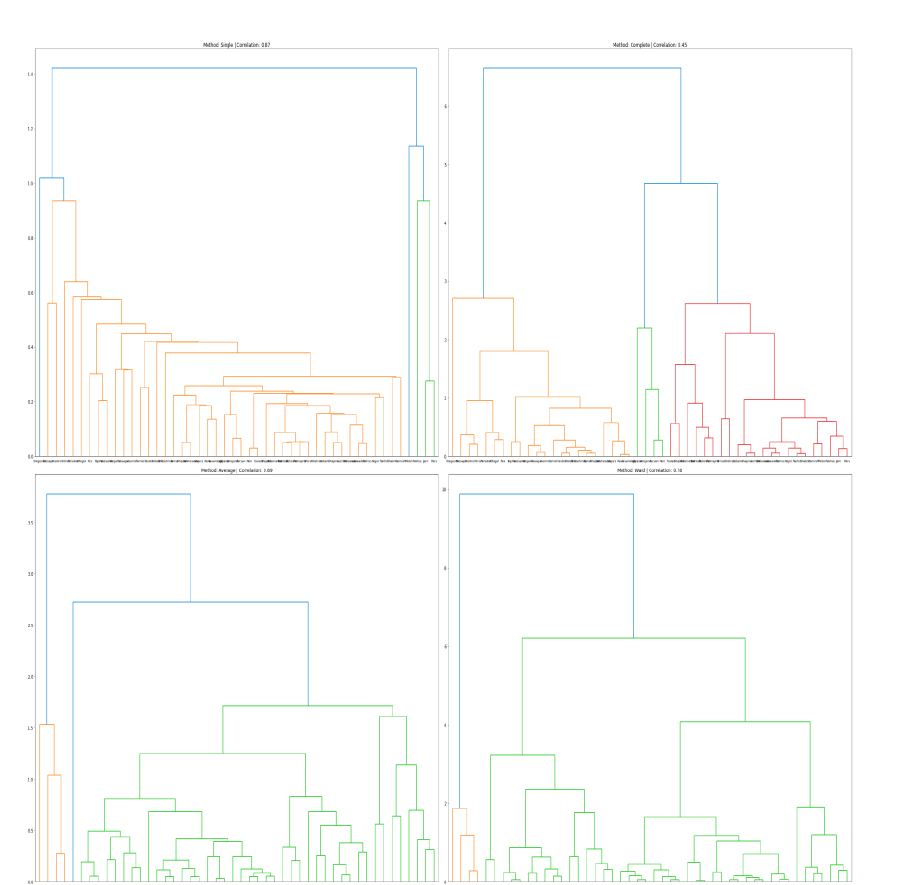
Figure 8. Compare Different linkage methods